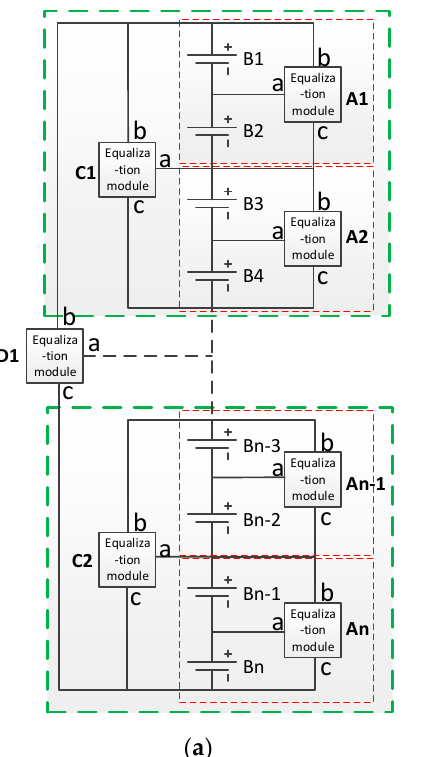
Figure 1. Battery equalization circuit topology: ( a ) Battery equalization structure diagram; ( b ) Schematic of the equalization module.